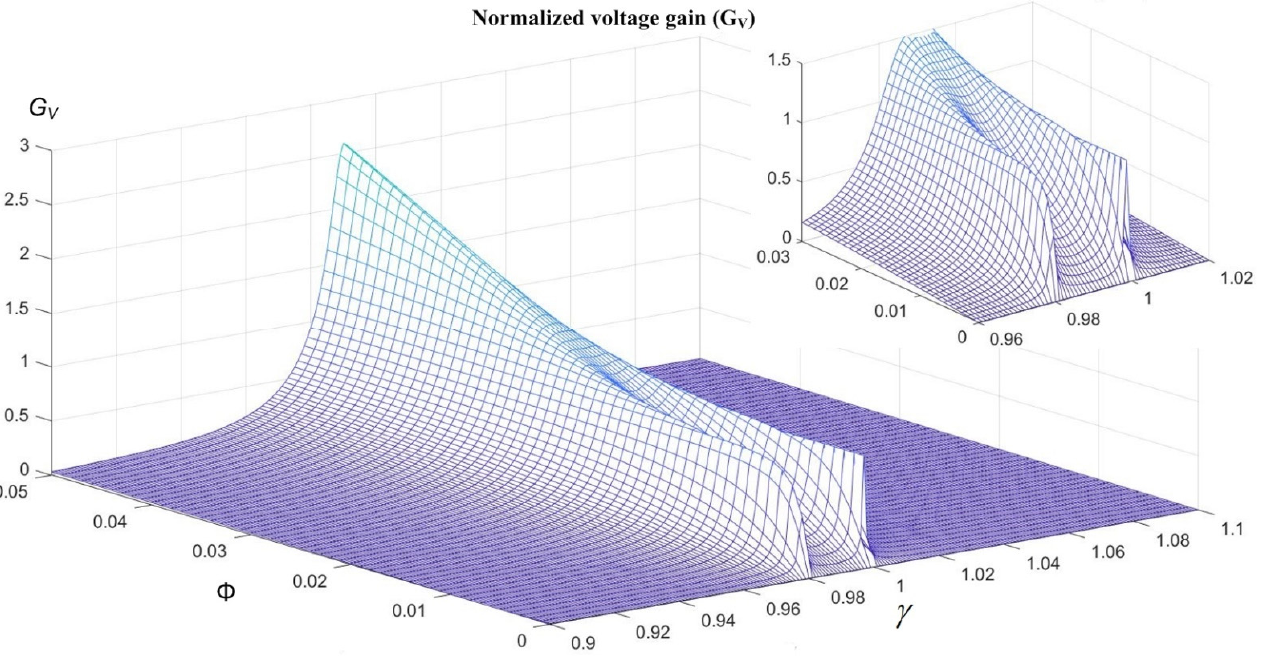
Figure 8. Normalized voltage gain in the function of γ , ϕ , and m = 50.